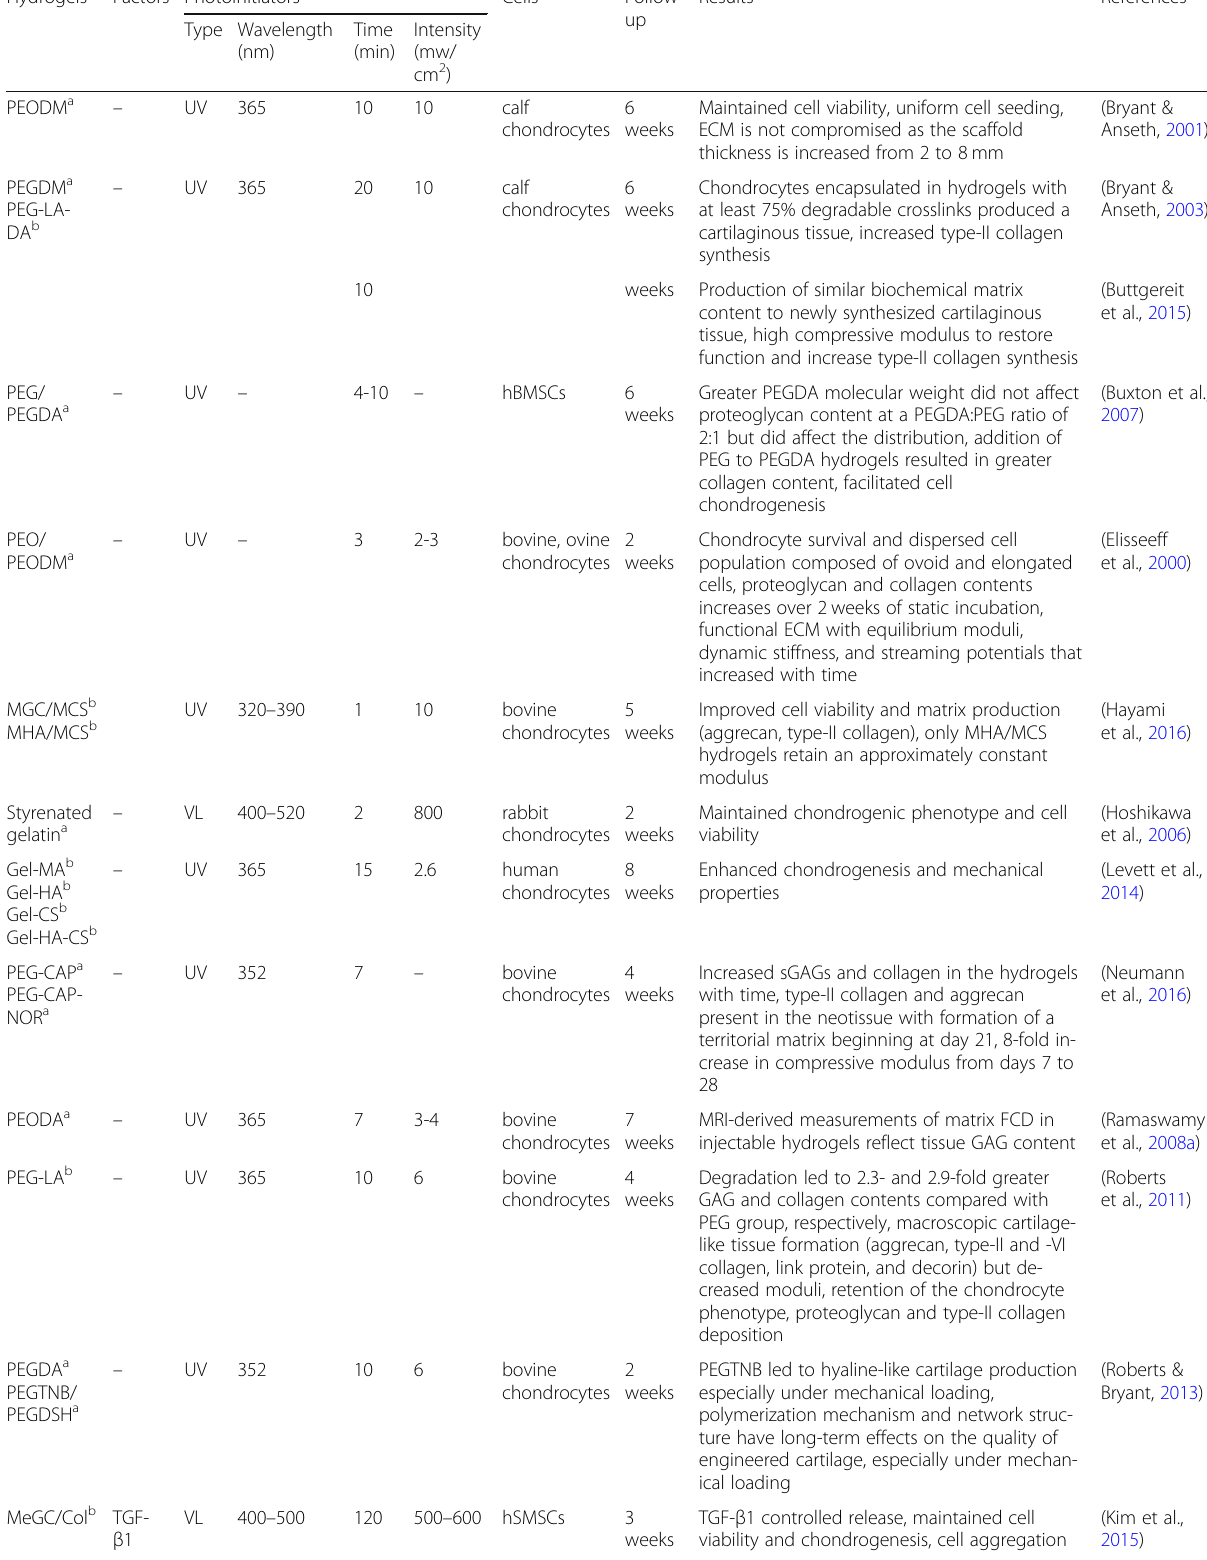
Table 1 Use of photopolymerizable hydrogels in vitro for applications in cartilage research